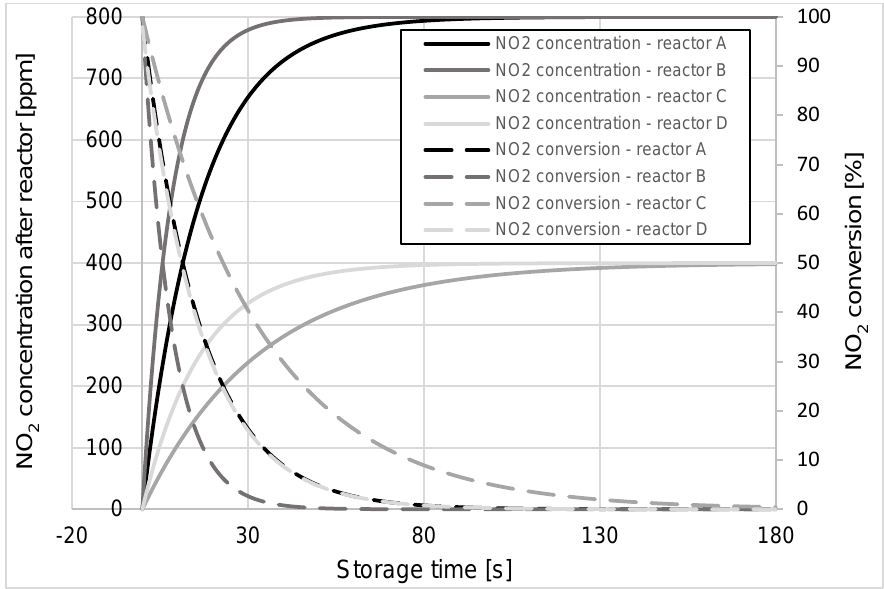
Figure 4. Changes in NO 2 concentration and its conversion during the storage process in A, B, C, and D reactors at the operating temperature of 350 °C .